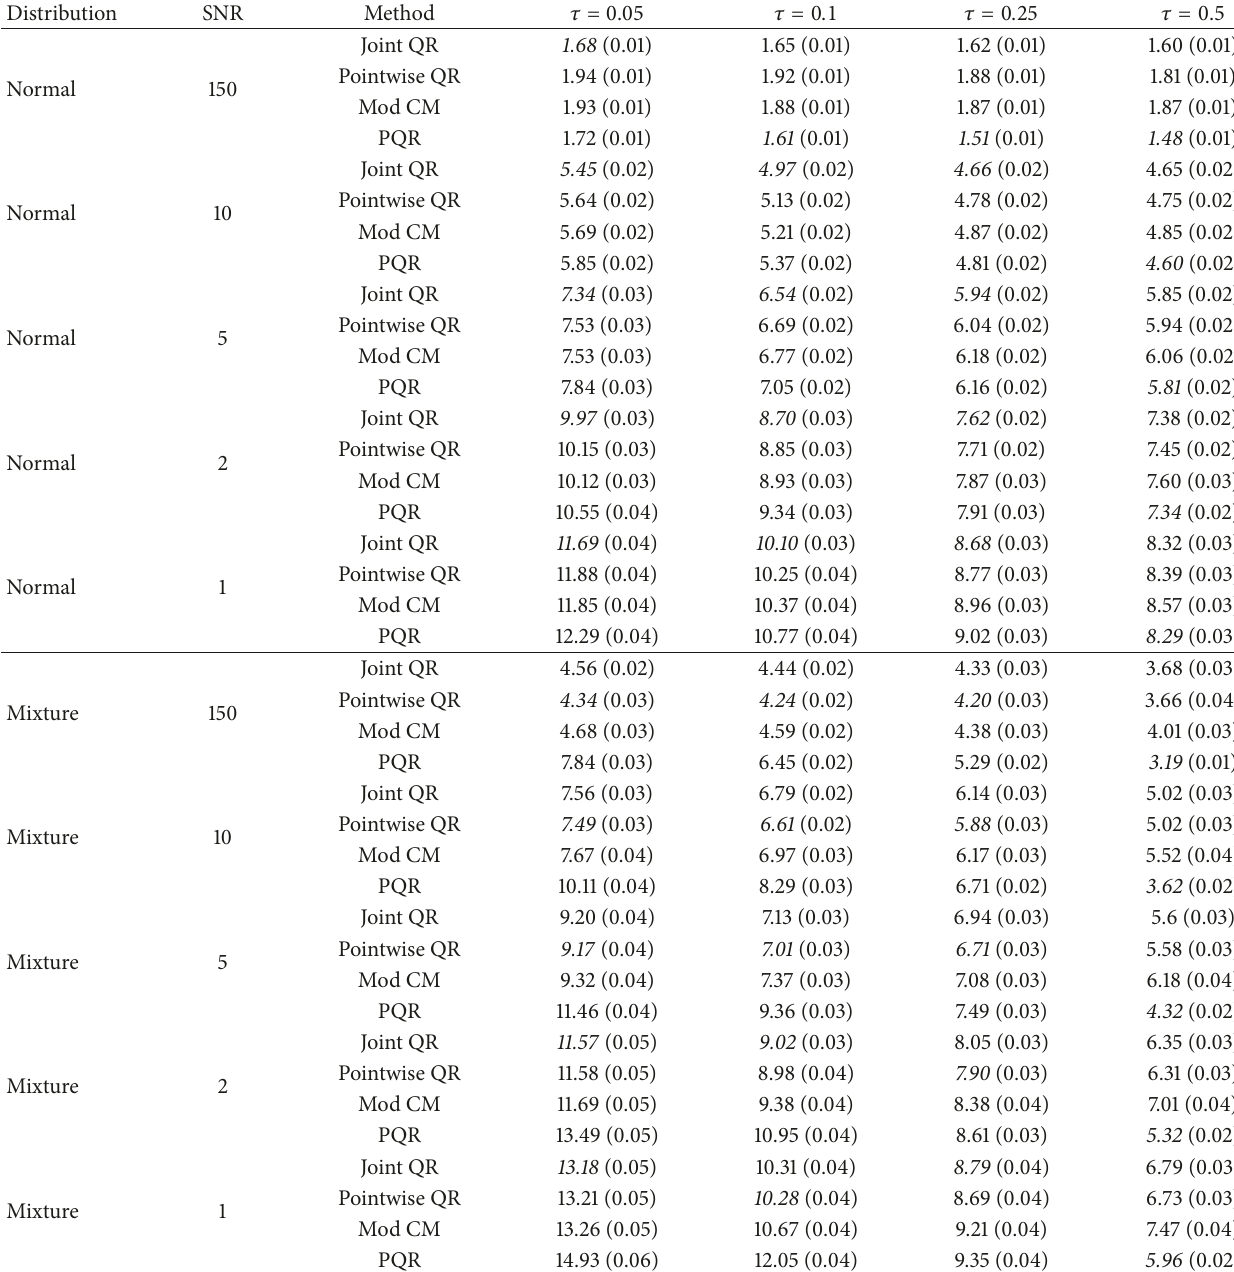
Table 2: Average MAE (standard error in parentheses) of the predicted 𝜏 -level quantile for the case of having a scalar covariate and a sparsely observed functional covariate. Sample size 𝑛 = 1000